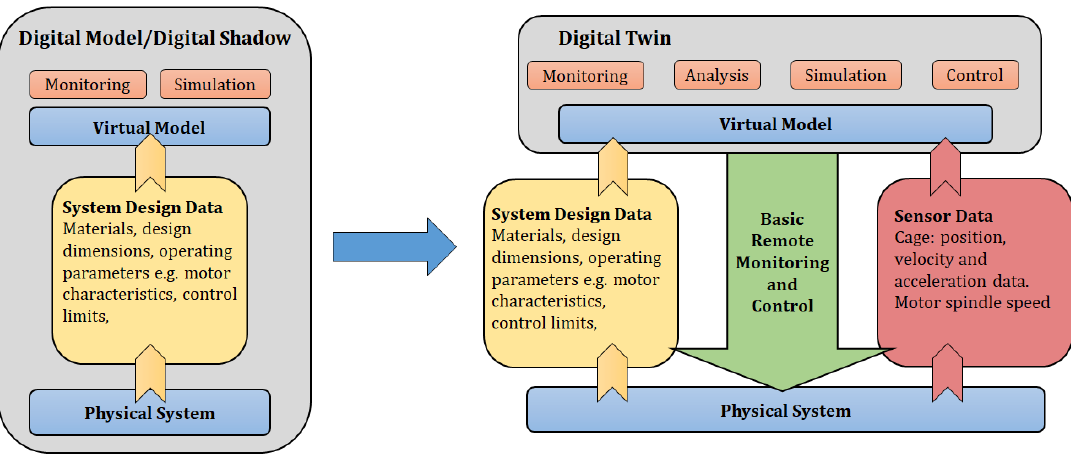
Figure 1. Illustration of the evolution from Digital Model and Digital Shadow to Digital Twin